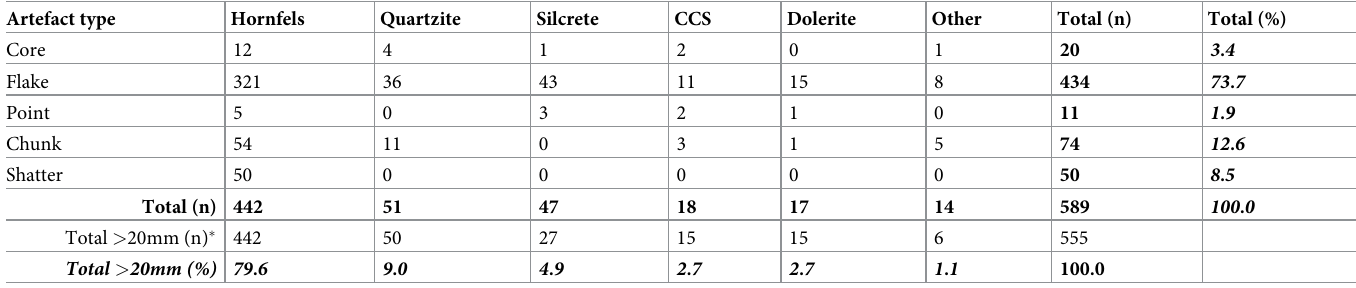
Table 3. Artefact frequencies recorded in complete grid squares 18/+3, 18/+4 and 18/+5, sampling all artefacts > 20mm hornfels and > 10mm all other raw materials. Artefact